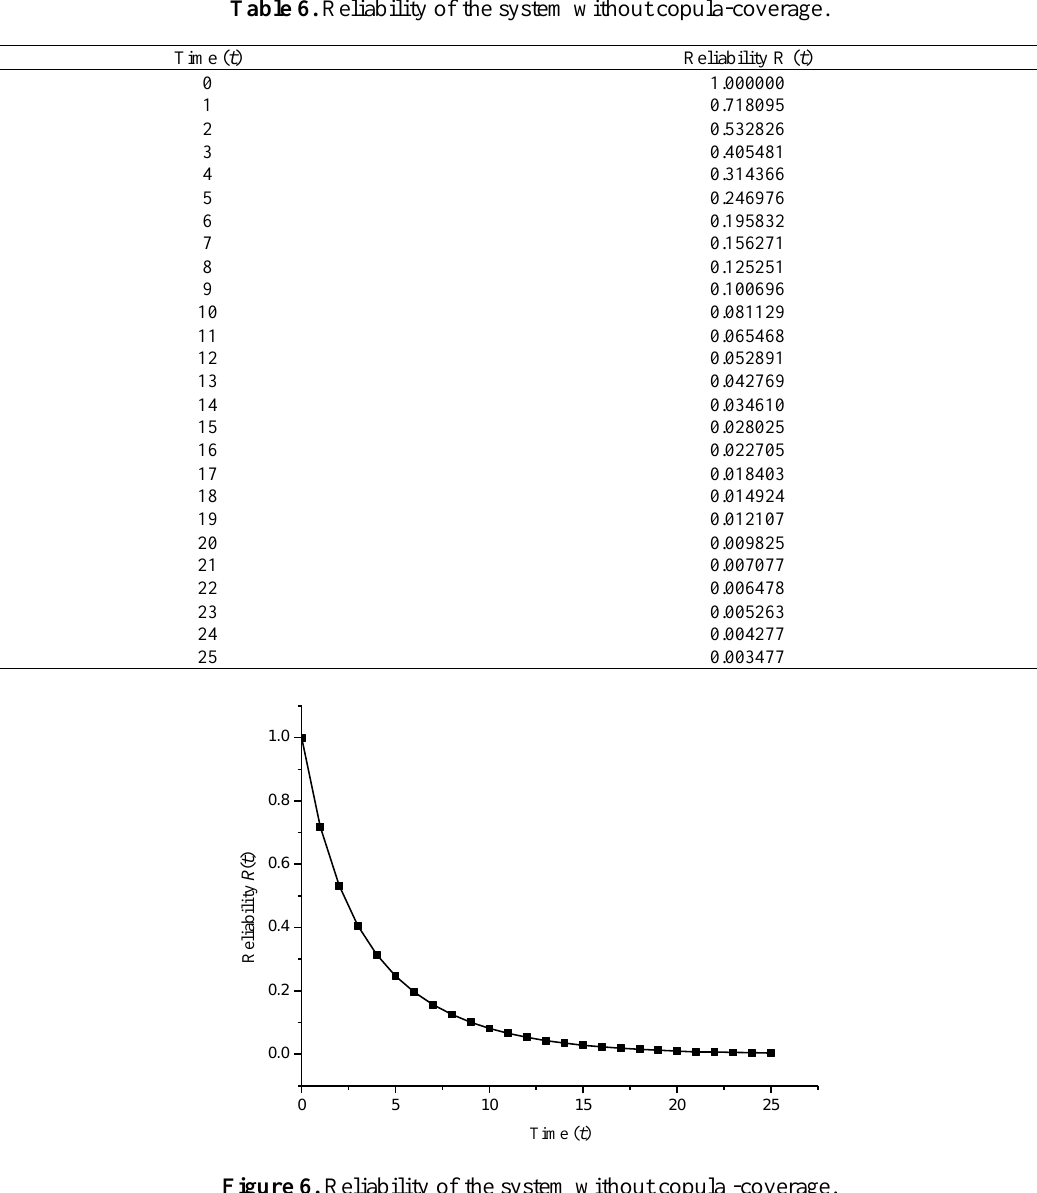
Table 6. Reliability of the system without copula-coverage.